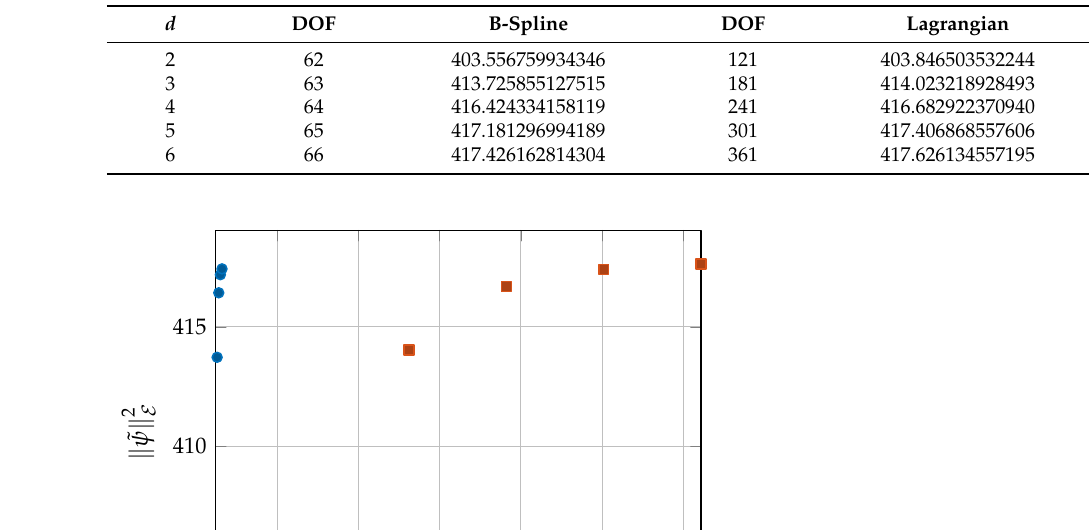
Table 11. Space-time energy norm squared (60), varying d and fixing ∆ t = 2 − d ∆ x .